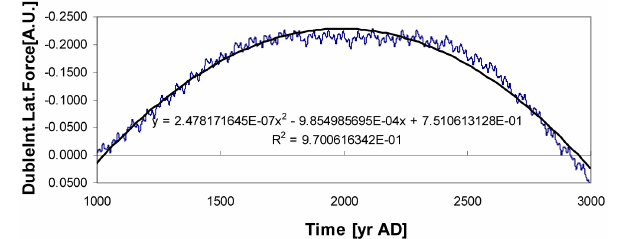
Figure B6. A comparison of the Hale solar cycle of SSN and the Fourier Series (with only two harmonics) model of the F signal. A lead of 0.5 years is applied to the SSN to improve the match with the F recurrent model.